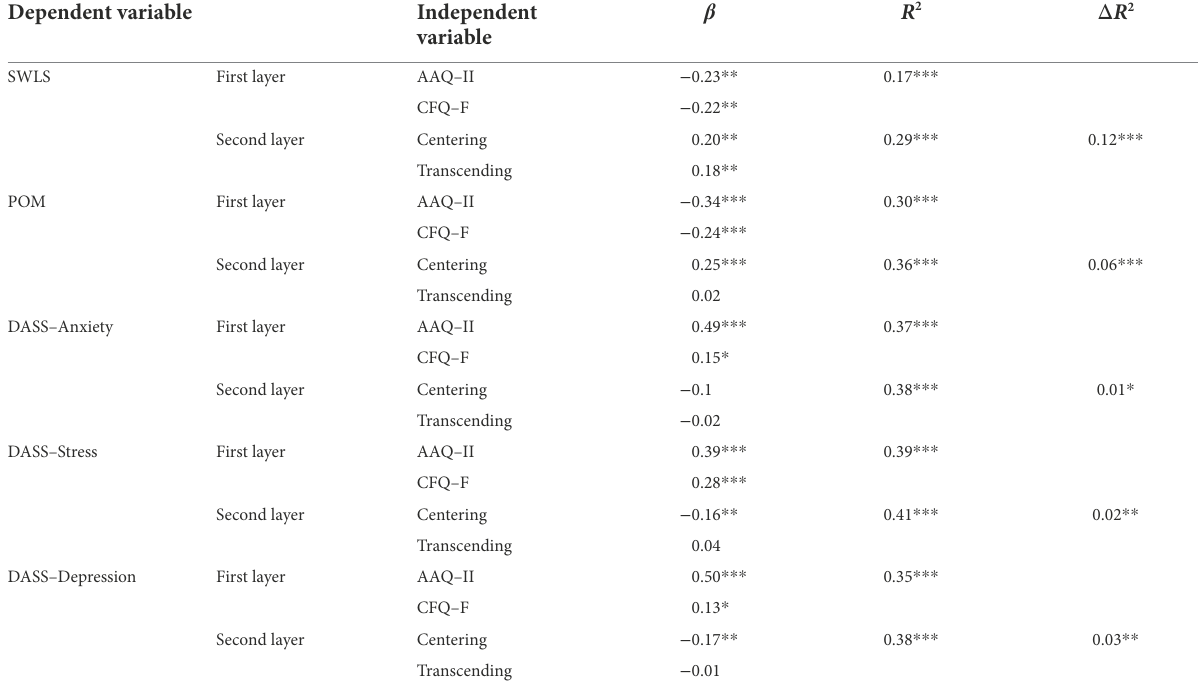
TABLE 5 Incremental validity of